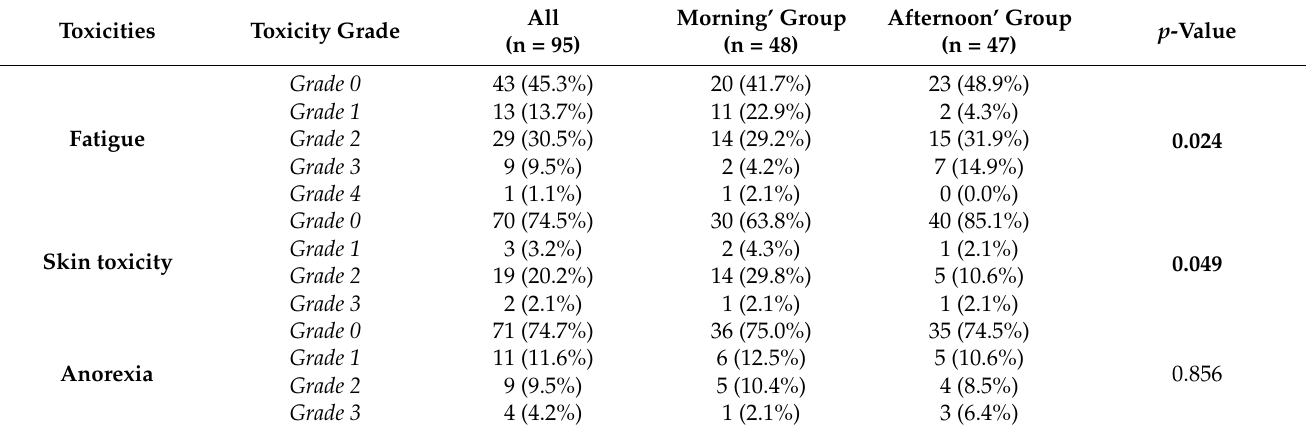
Table 2. Toxicity grades in all 95 patients and separately in ‘morning’ and ‘afternoon groups.